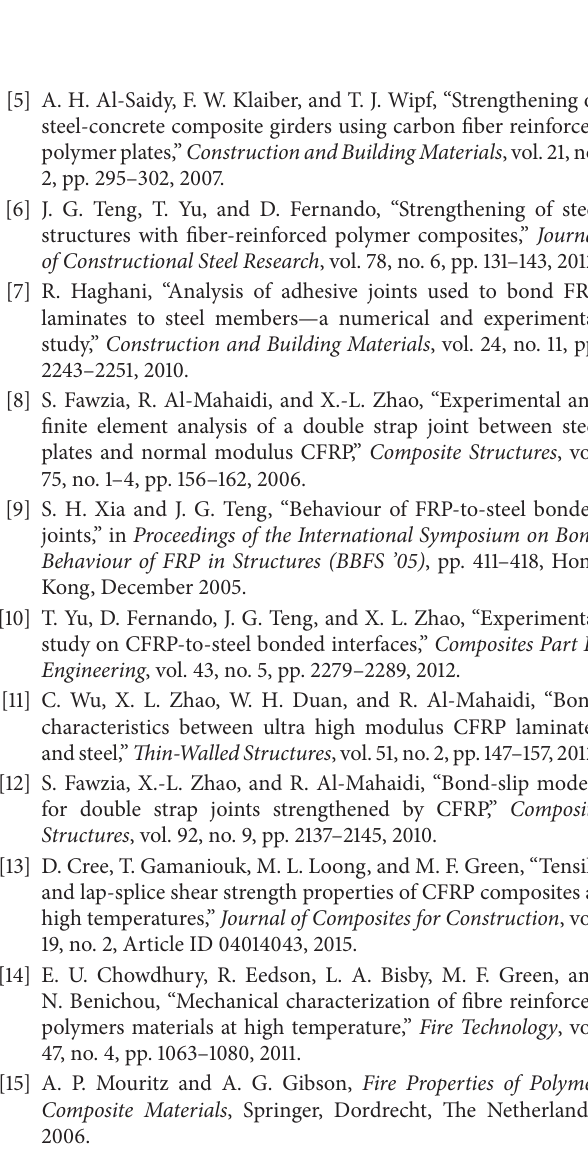
Figure 9: Effect of elevated temperatures on (a) 𝜏 max and (b) 𝑠 max